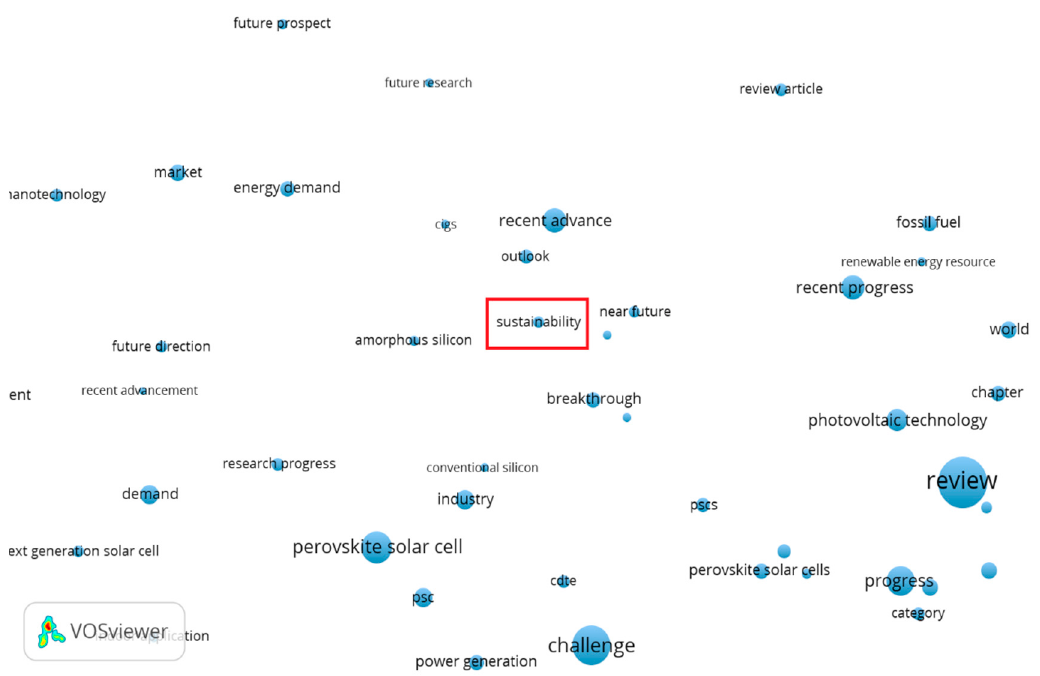
Figure 3. Zoomed illustration of the terms from titles and abstracts of DSSC papers to make “sustainability” visible.